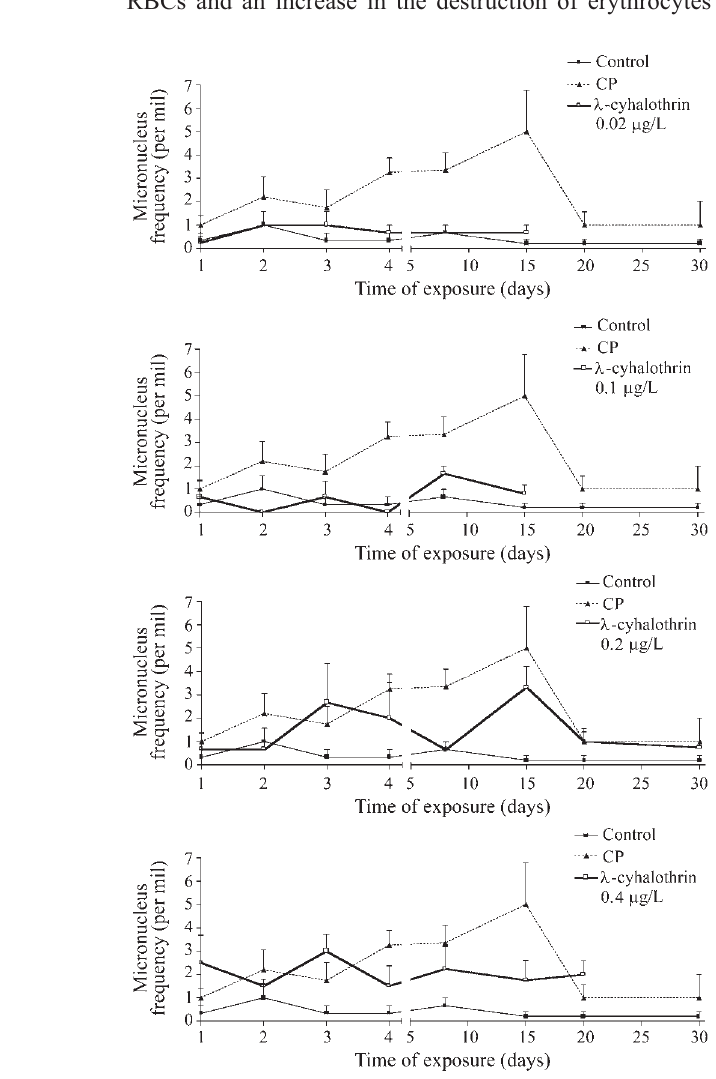
Figure2 -Variationinthemicronucleifrequencywithtimeineachtreated group. Each graph show control, CP (positive control) and the concentra- tion of lambda-cyhalothrin tested. Data are the mean ±